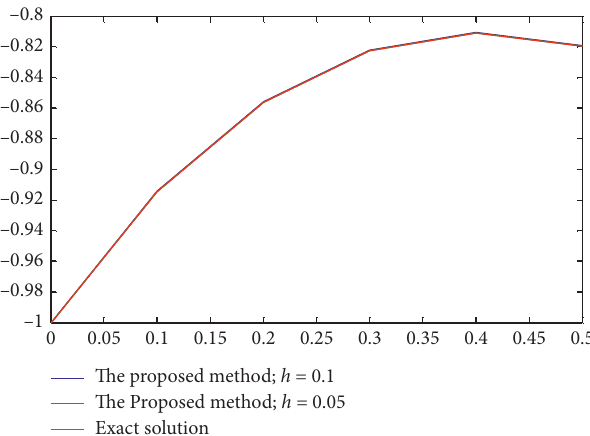
Figure 6: Numerical solutions using the proposed method and exact solution for Example